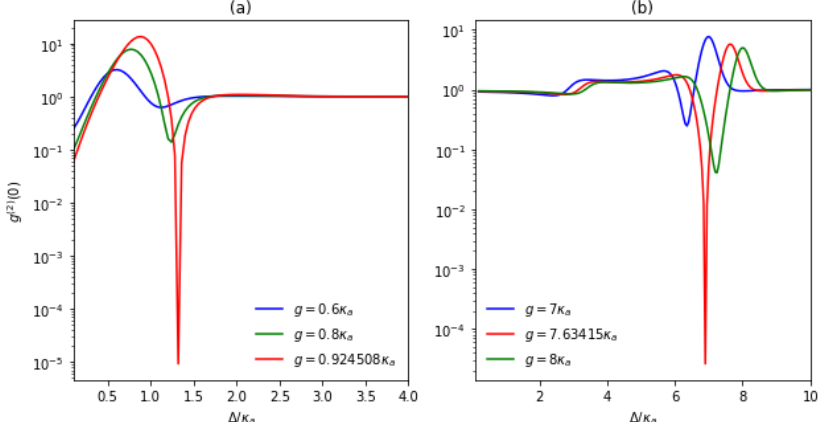
Figure 8. Plots of equal-time second-order correlation function g ( 2 ) ( 0 ) as a function of the scaled detuning for ( a ) g = 0.6 κ a , g = 0.8 κ a , and g = 0.924508 κ a ; ( b ) g = 7 κ a , g = 7.63415 κ a , and g = 8 κ a with fixed J = 2.5 κ a . Other parameters are the same as in Figure 4.